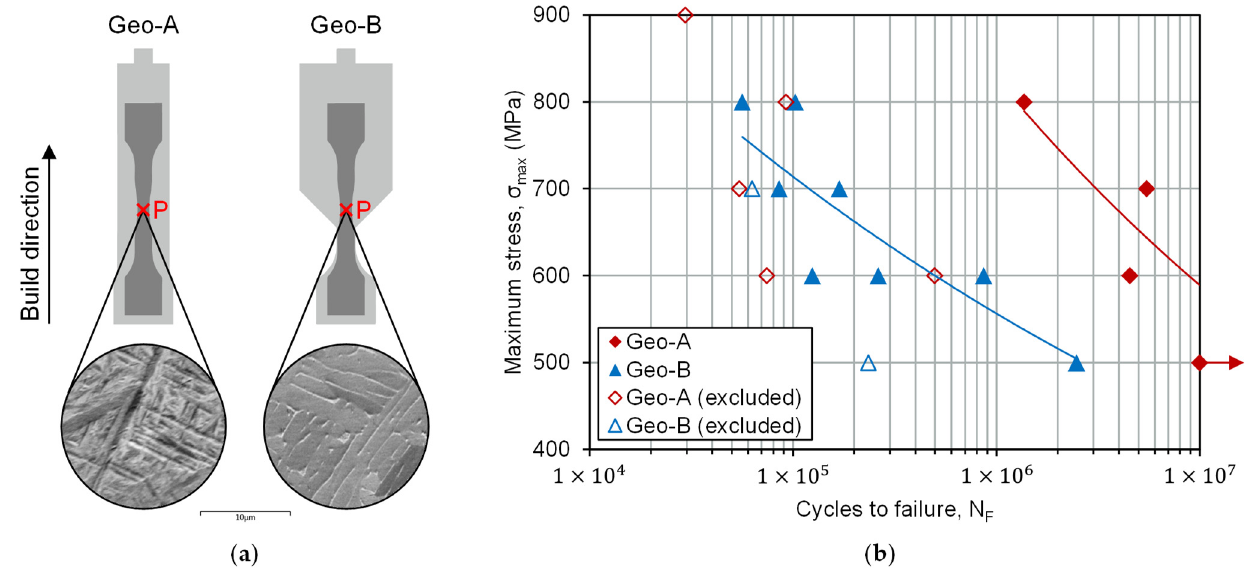
Figure 8. Geometry effect on fatigue life based on geometry variants Geo-A and Geo-B, ( a ) Geo-A and Geo-B with corresponding microstructure at evaluation point P, ( b ) Fatigue life of Geo-A and Geo-B, R = 0.1, samples with crack initiation at pore defects excluded (unfilled data points).